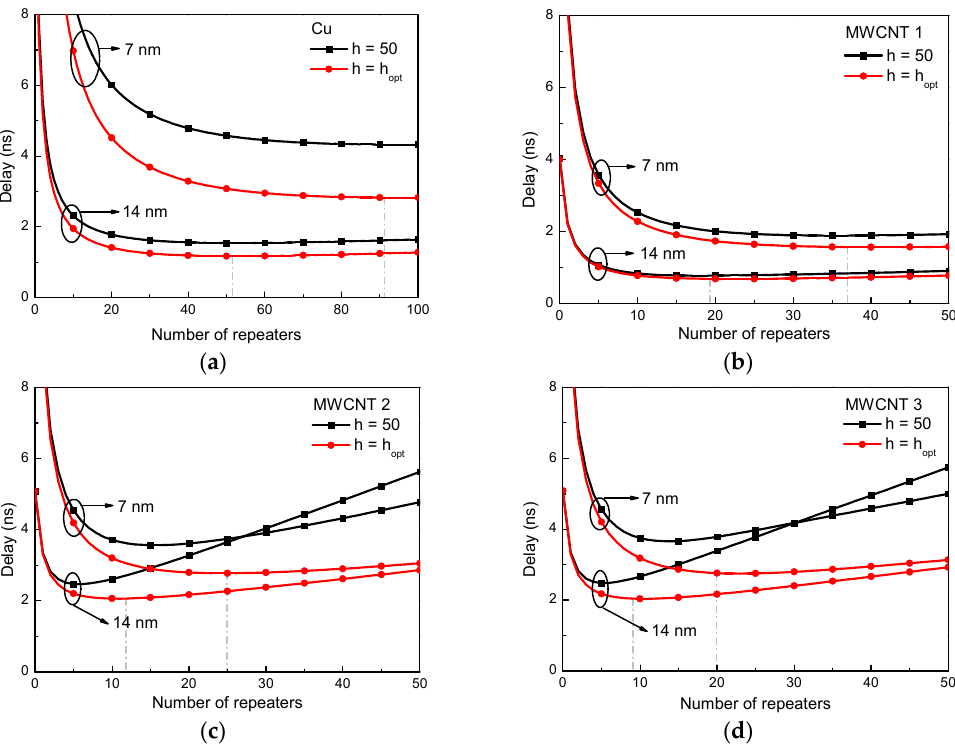
Figure 7. Propagation delays versus number of repeaters for 2000- µ m-long global-level Cu and MWCNT interconnects. ( a ) Cu; ( b ) MWCNT 1; ( c ) MWCNT 2; and ( d ) MWCNT 3. Table 4. Comparison of the simulated and estimated optimal number of repeaters, repeater size, and minimum time delay in 2000- µ m-long global-level Cu and MWCNT interconnects at the 14 nm and 7 nm technology